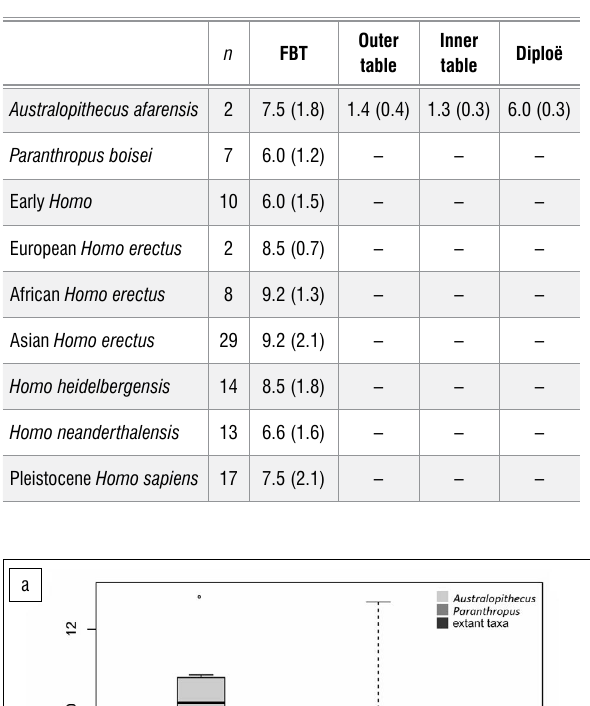
table 3: Mean frontal bone thickness (FBT, mm) of human and non- human hominin species from Copes and Kimbel 16 . Standard deviations are shown in brackets.